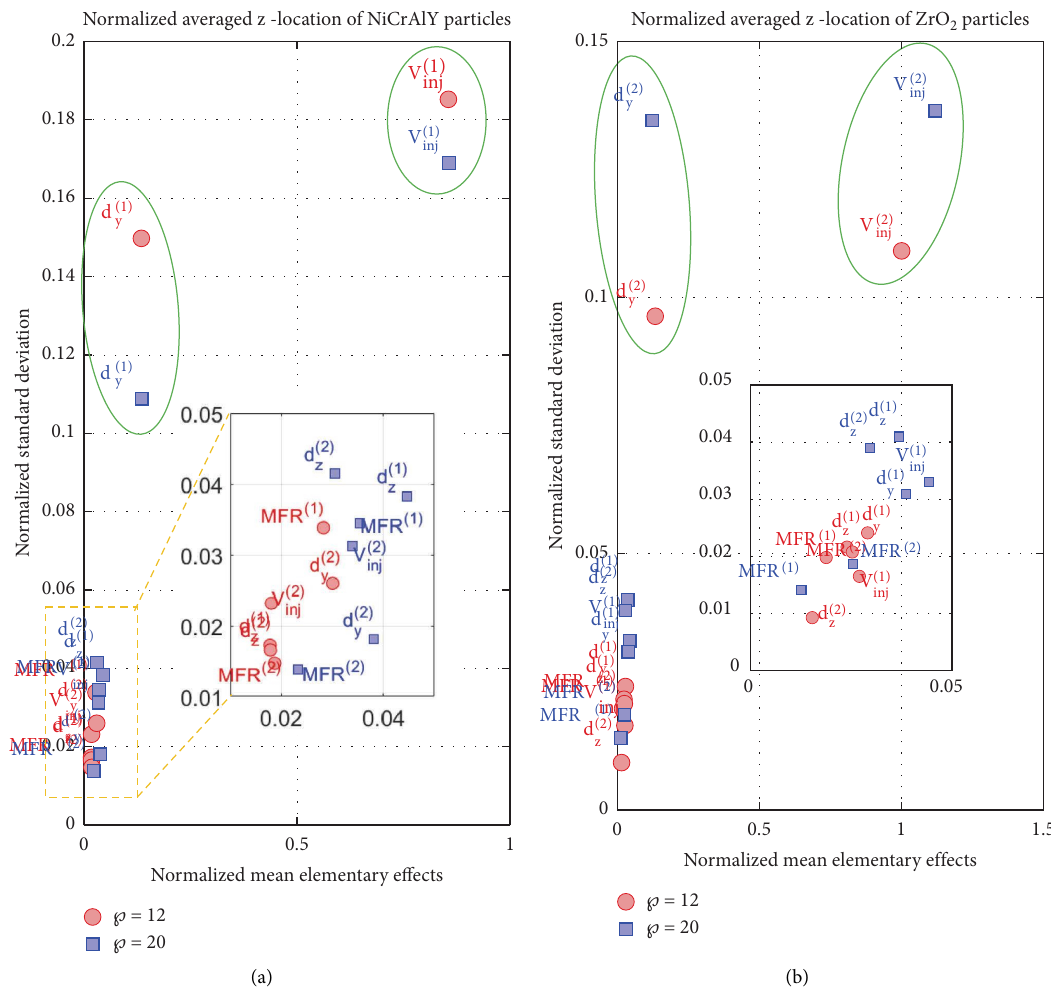
Figure 6: Normalized standard deviation vs. normalized mean EEs for the normalized (z)-locations of (a) NiCrAlY and (b) ZrO the observation window (meanings of other symbols are: V ( 1 ) inj , V ( 2 ) inj � average injection velocities, respectively, of NiCrAlY and ZrO 2 particles; d ( 1 ) y , d ( 2 ) y � (y) – locations, respectively, of NiCrAlY and ZrO 2 injectors; d ( 1 ) z , d ( 2 ) z � (z) – locations, respectively, of NiCrAlY and ZrO 2 injectors; MFR ( 1 ) , MFR ( 2 ) � mass fow rate, respectively, of NiCrAlY and ZrO 2 powder